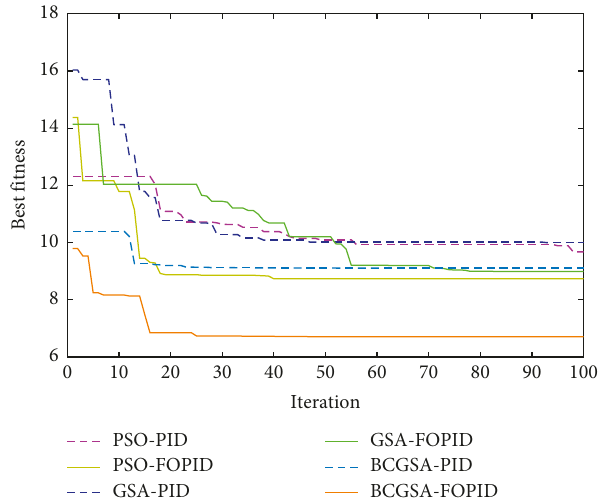
Figure 11: Convergence curves of objective function with Δ f � + 0 . 5Hz.